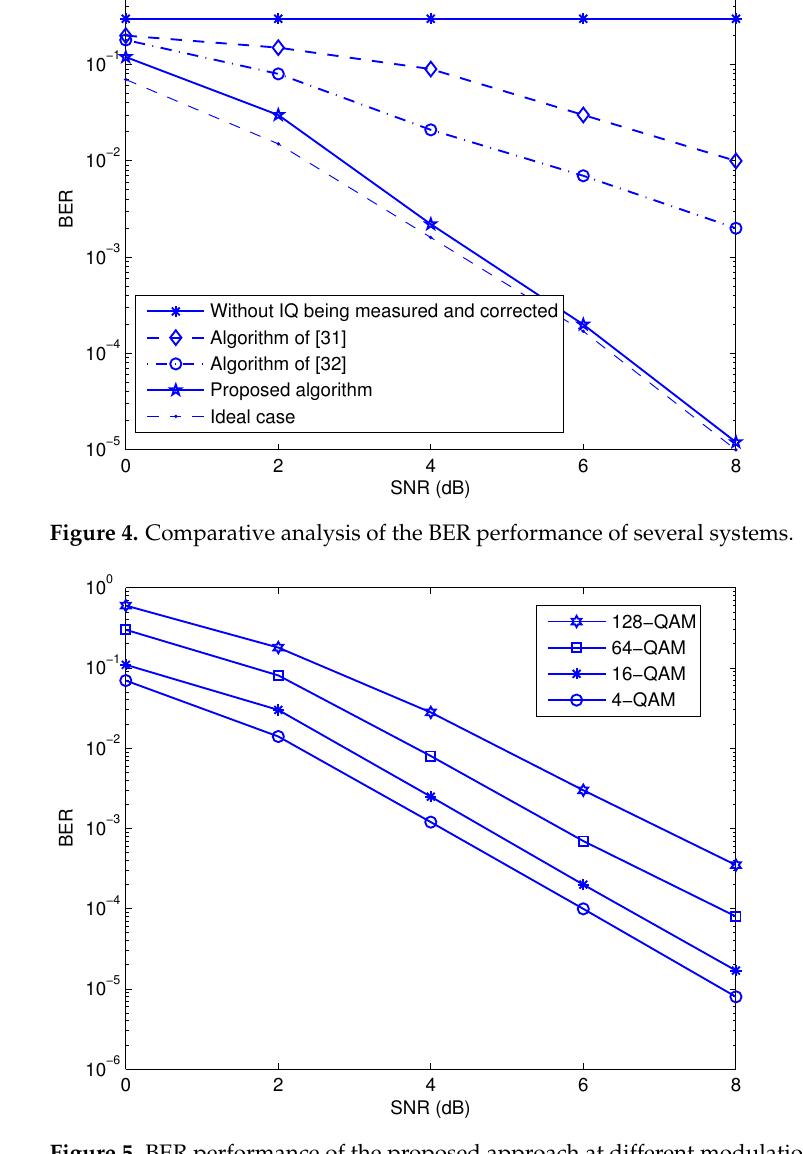
Figure 5. BER performance of the proposed approach at different modulation